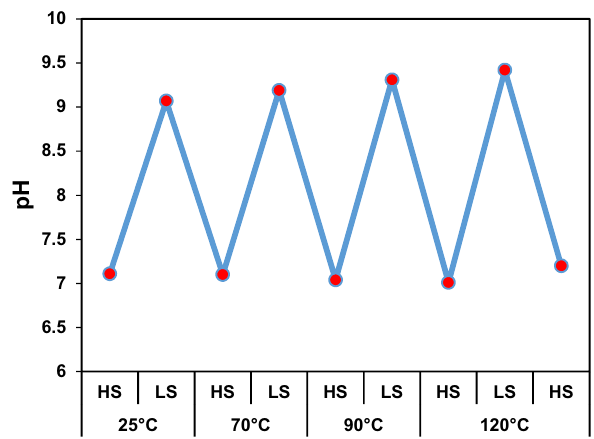
Fig. 9 Oil recovery test results for sandstone column#1 (sand + illite)